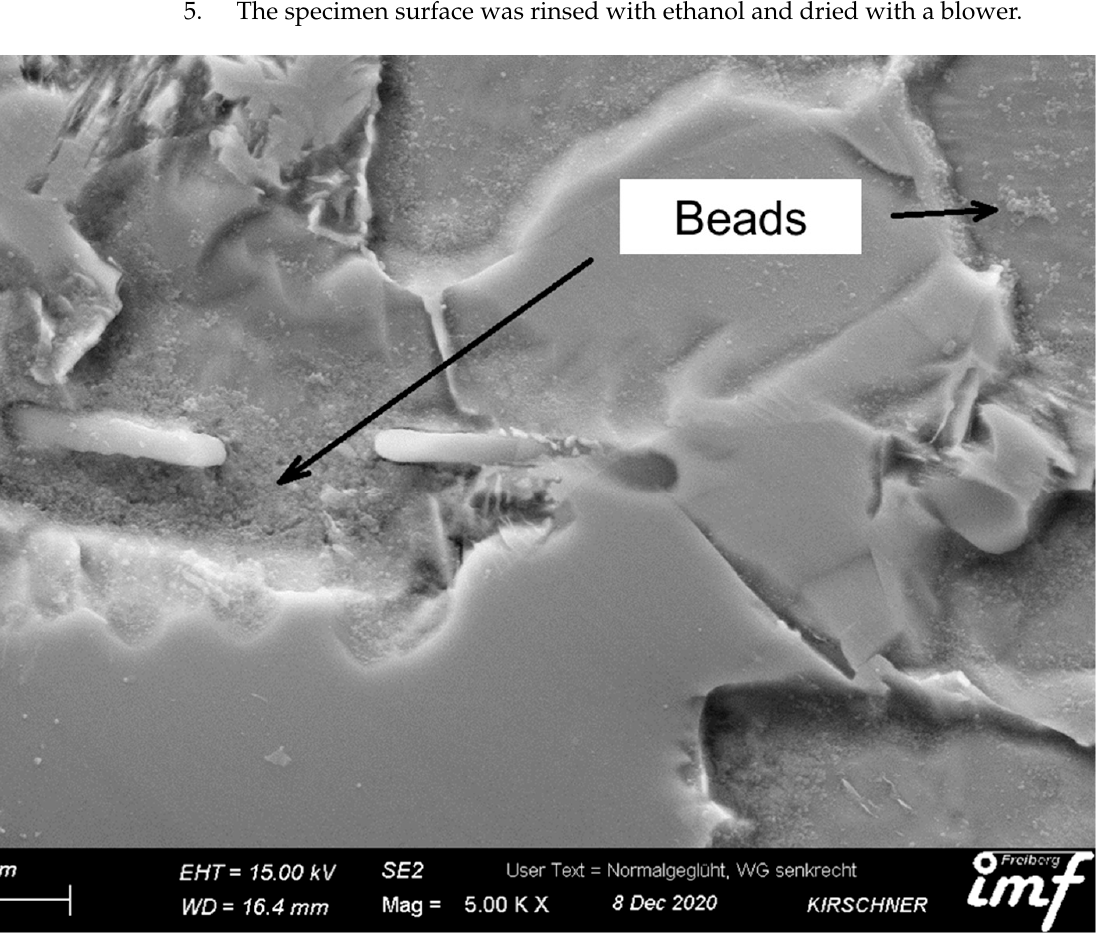
Figure A2. Example of the accumulation of polystyrene latex beads in the deep spots created by etching.